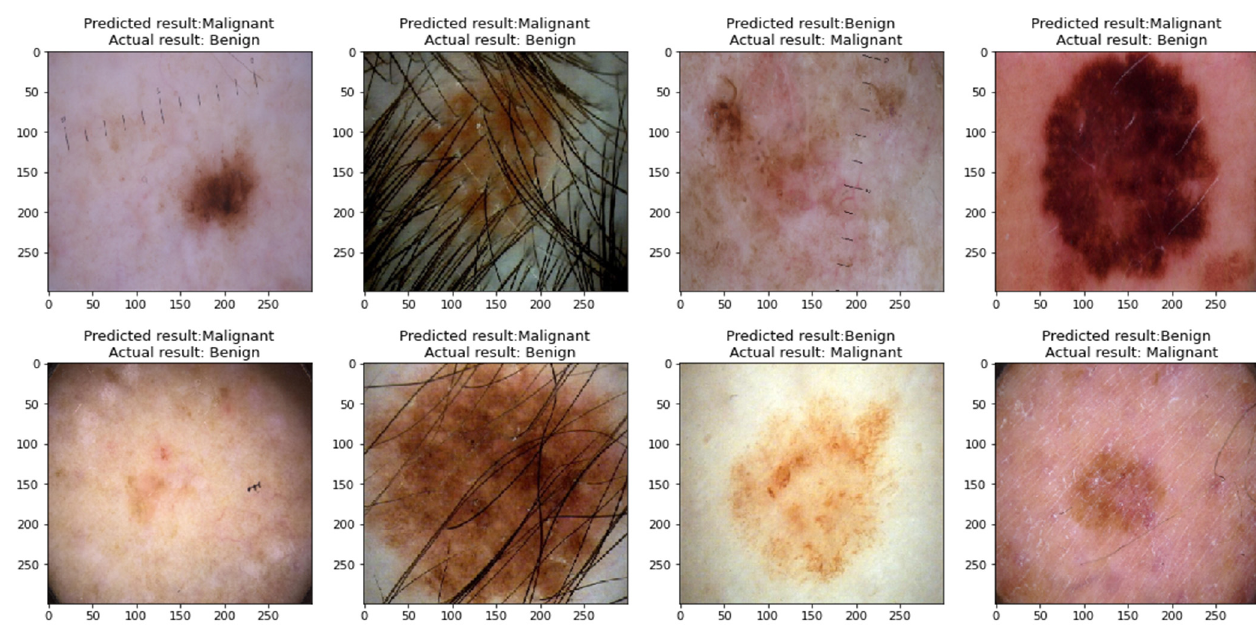
Figure 20. Misclassified images by the classifier of the proposed approach.